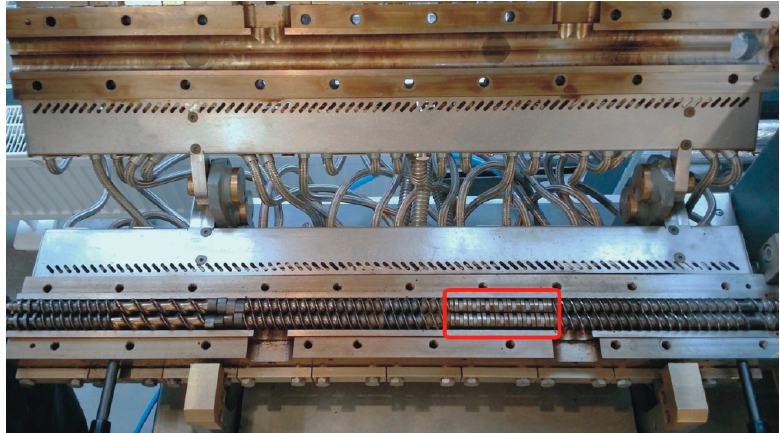
Figure 1. View of an open cylinder of the plasticizing system of an extruder with screws in one of the tested configurations, with a border-marked test segment.